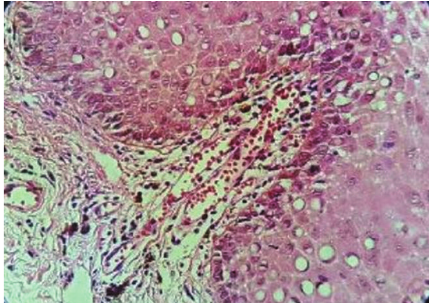
Figure 2: Biopsy of pigmentation on buccal mucosa indicates increased basilar melanin with melanin incontinence into the submucosa (H&E staining).